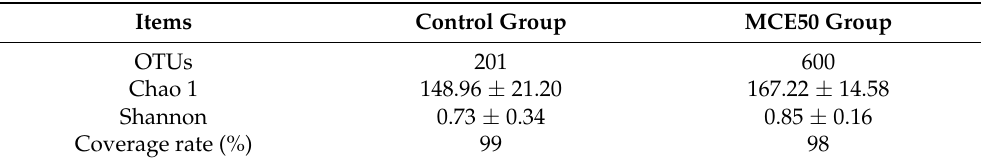
Table 5. Comparison of alpha diversity of intestinal microbiota of juvenile American eel between the control group and MCE50